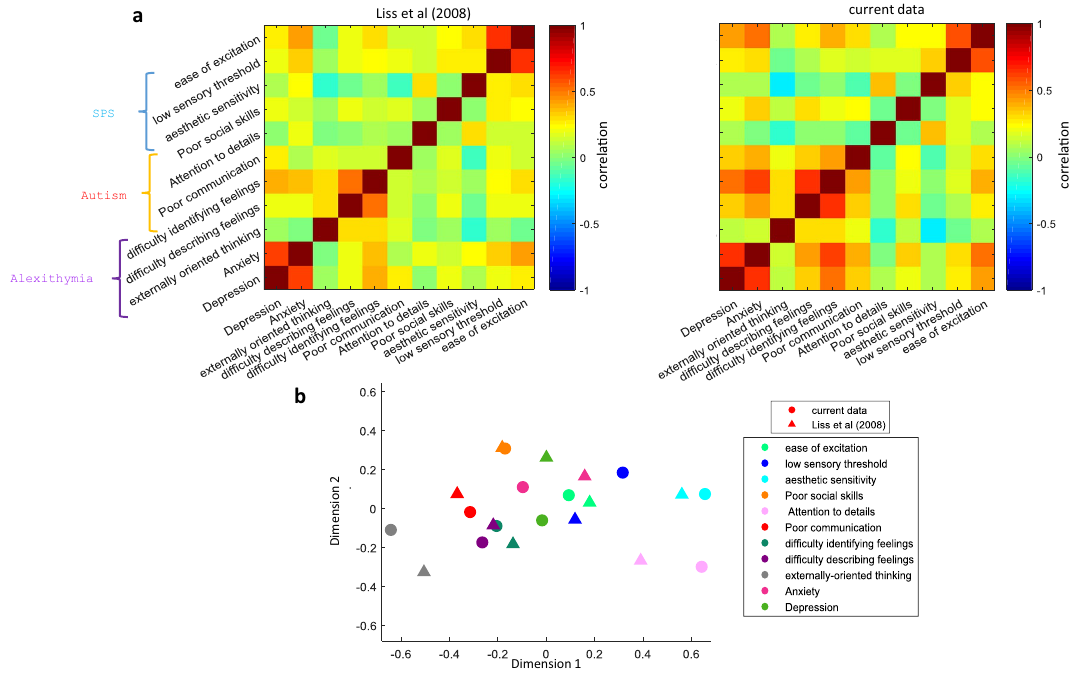
Figure 5. Trait score comparison with previously published data. ( a ) Color-coded correlation matrix of anxiety, depression, and subdomains of HSPS, autism, and alexithymia for Liss et al. 5 and current data. ( b ) 2D embedding of trait scores using MDS (Methods) using the correlation matrix provided by Liss et al. (triangles) and the current data (circles) with colors showing different traits or their